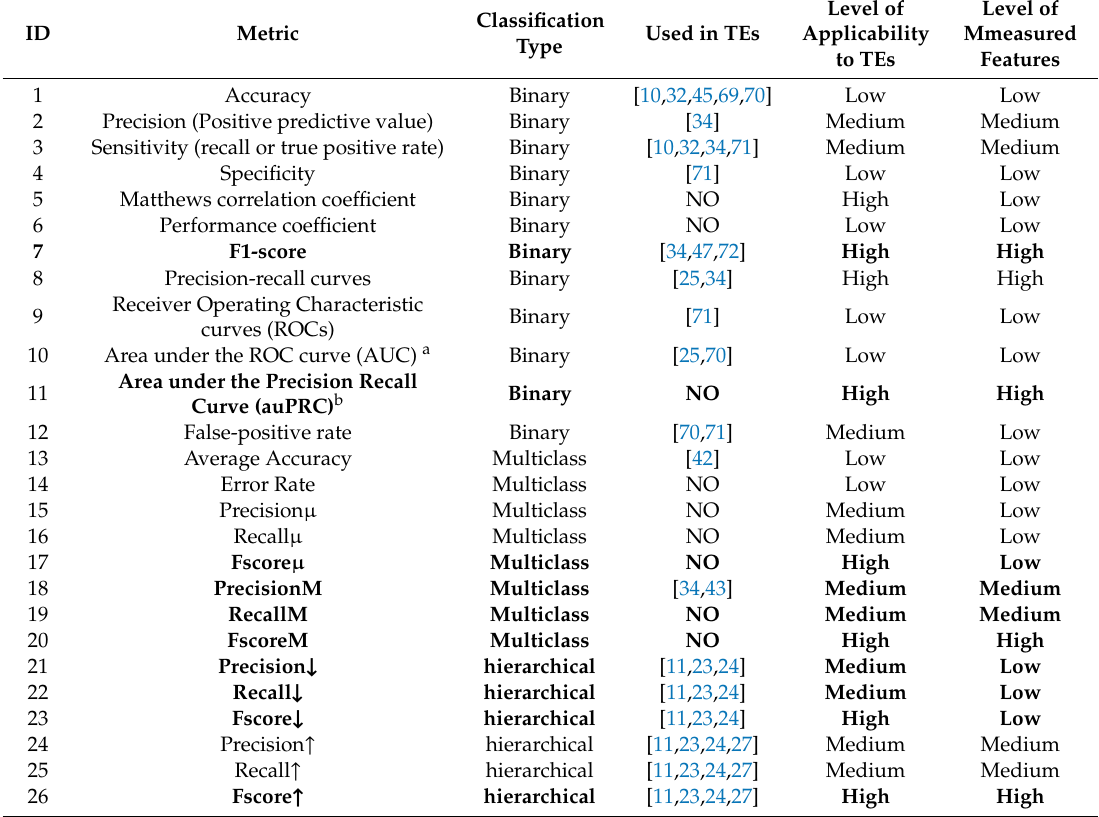
Table 5. Metrics used in classification problems. Adopted from